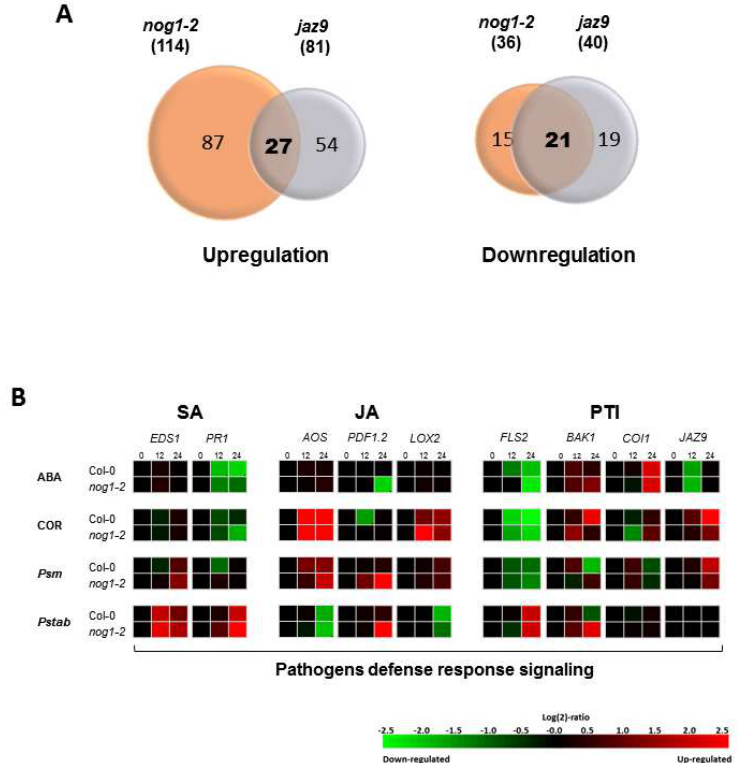
Figure 5. Gene expression profiling in Arabidopsis nog1-2 and jaz9 mutants. ( A ) Venn diagram showing the number of up and downregulated genes in nog1-2 and jaz9 mutants compared to wild-type (Col-0) with an overlap. Numbers in parenthesis are genes differentially expressed in a respective genotype. ( B ) Expression profiling of genes involved in SA and JA signaling pathways in Col-0 and nog1-2 . Three-week-old Arabidopsis seedlings grown in MS medium were inoculated with ABA (100 nM), COR (20 nM), P . syringae pv. maculicola ( Psm : 1 × 10 6 CFU/mL) and P . syringae pv. tabaci ( Pstab : 1 × 10 6 CFU/mL) and samples were collected at 0, 12, and 24 h after inoculation for RNA extractions. qRT-PCR analysis was performed with three biological and three technical replications. EDS1 : Enhanced Disease Susceptibility 1, PR1 : Pathogenesis-Related Gene 1, AOS : Allene Oxide Synthase, PDF1.2 : Plant Defensin 1.2, LOX2 : Lipoxygenase, FLS2 : Flagellin Sensitive 2, BAK1 : BRI 1-Associated Receptor Kinase 1, COI1 : Coronatine Insensitive 1, PTI: PAMP triggered